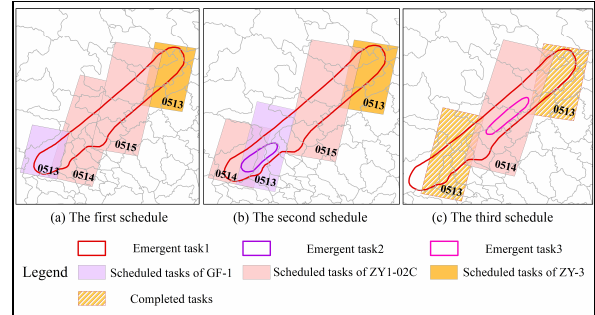
Figure 5. The simulated result